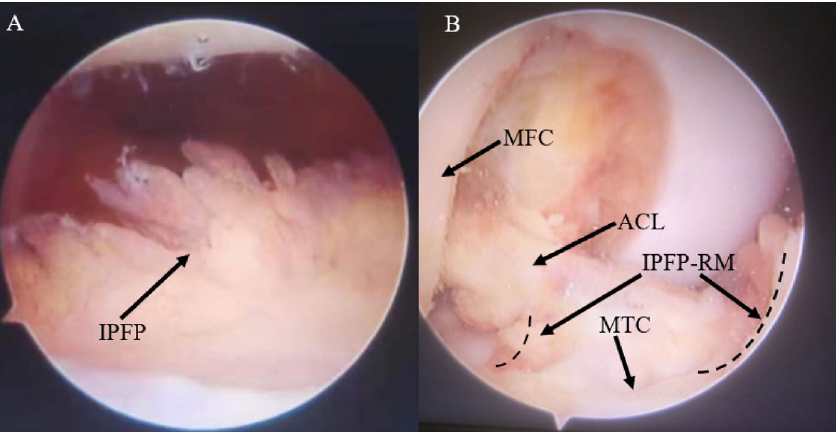
Figure 1. Representative intraoperative visualization in the infrapatellar fat pad resection group. ( A ) The intra-articular structure was obscured by infrapatellar fat pad under arthroscopy. ( B ) The extent of resection of infrapatellar fat ( IPFP infrapatellar fat pad, MFC medial femoral condyle, ACL anterior cruciate ligament, MTC medial tibial condyle, IPFP-RM infrapatellar fat pad resection